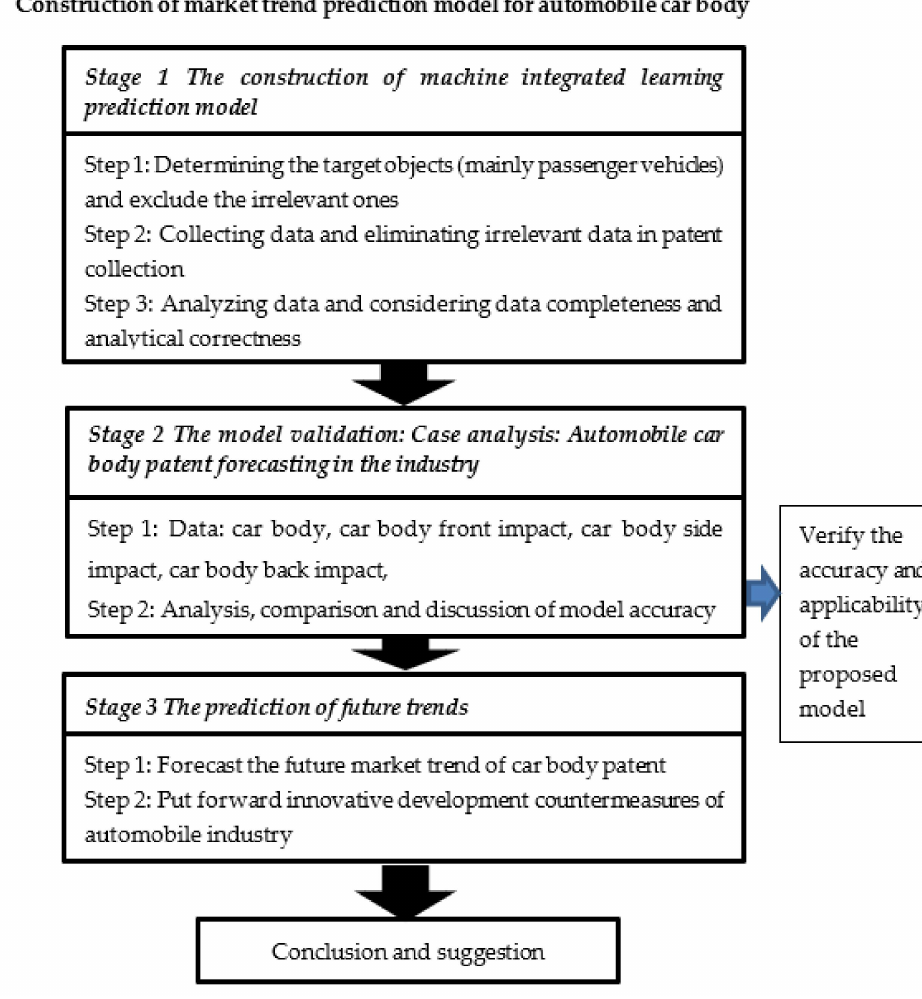
Figure 1. Research framework